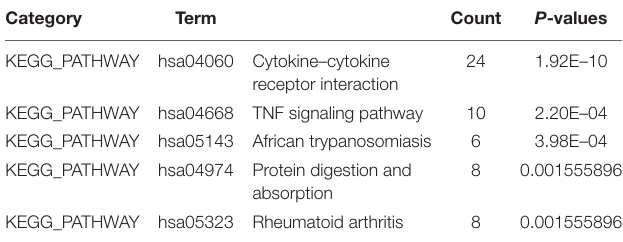
TABLE 3 | KEGG pathway analysis of DEGs. Category